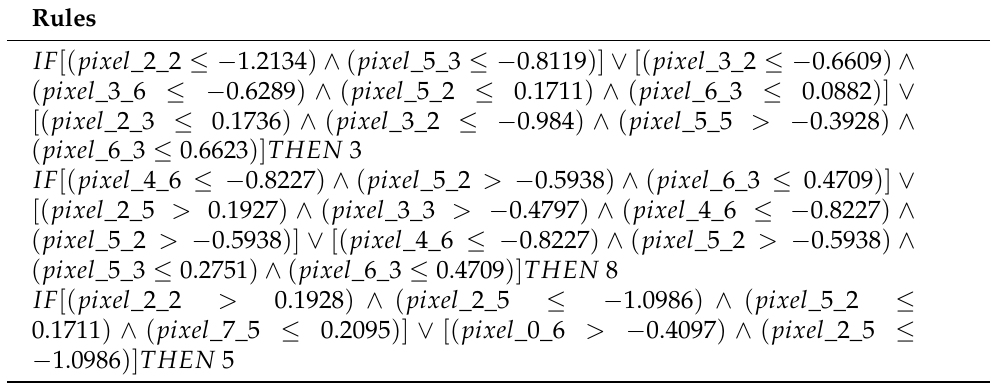
Table A17 shows the final rule set for the Digits dataset inducted by ECLAIRE. Table A17. Final rule set for the digits dataset generated by